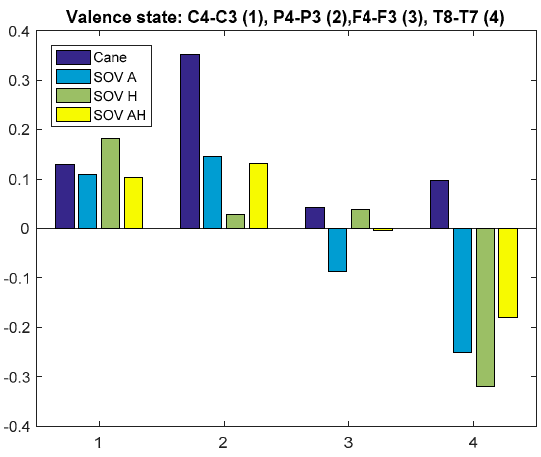
Figure 30. Average valence state (VS) for all visually impaired people (VIP).